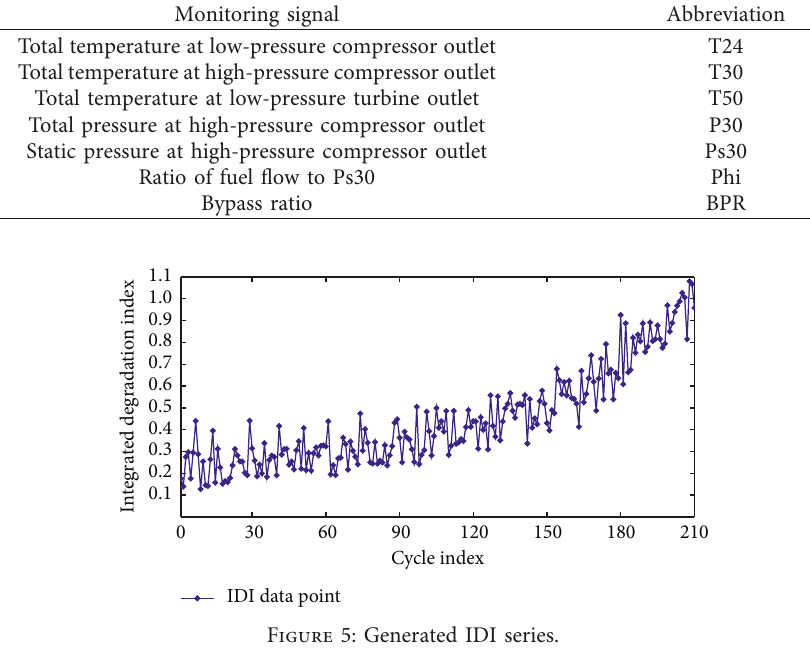
Figure 5: Generated IDI series.